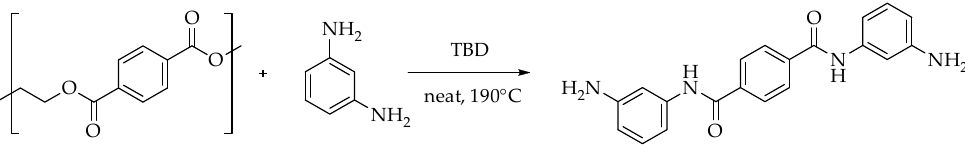
Figure 2. DSC thermograms of MPD − TPA − MPD at a heating rate of 10 °C/min. The melting temperature of the hardener was determined as 315 ◦ C by means of